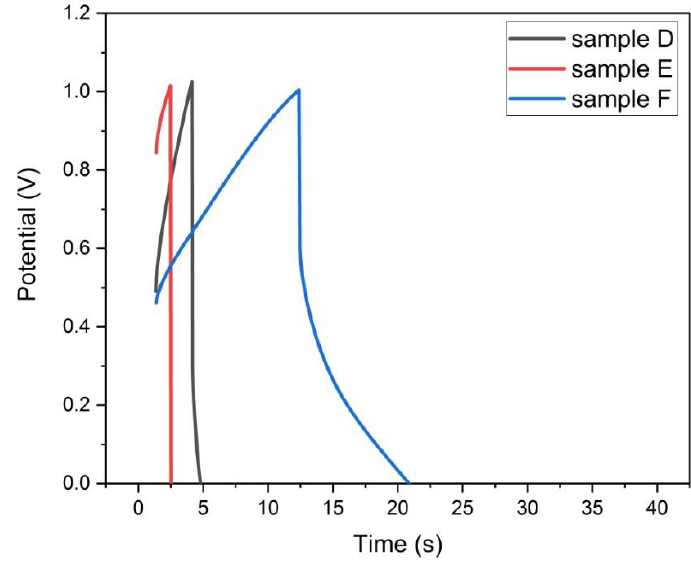
Figure 19. Galvanostatic charge–discharge plots of samples (D, E, and F) at 50